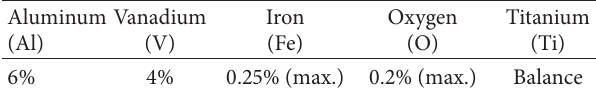
Table 1: Chemical composition of titanium (Grade-5) alloy. Aluminum